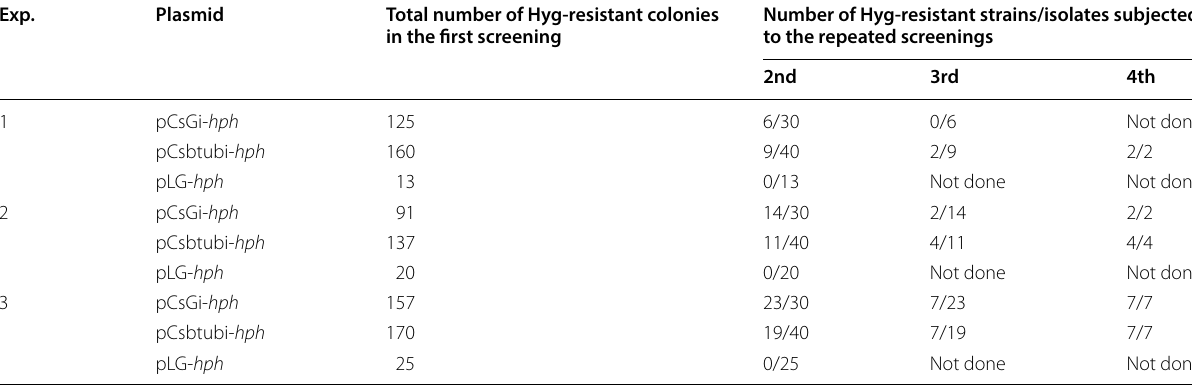
The number of colonies on the screening plates with 100 µg/ml of hygromycin B was counted